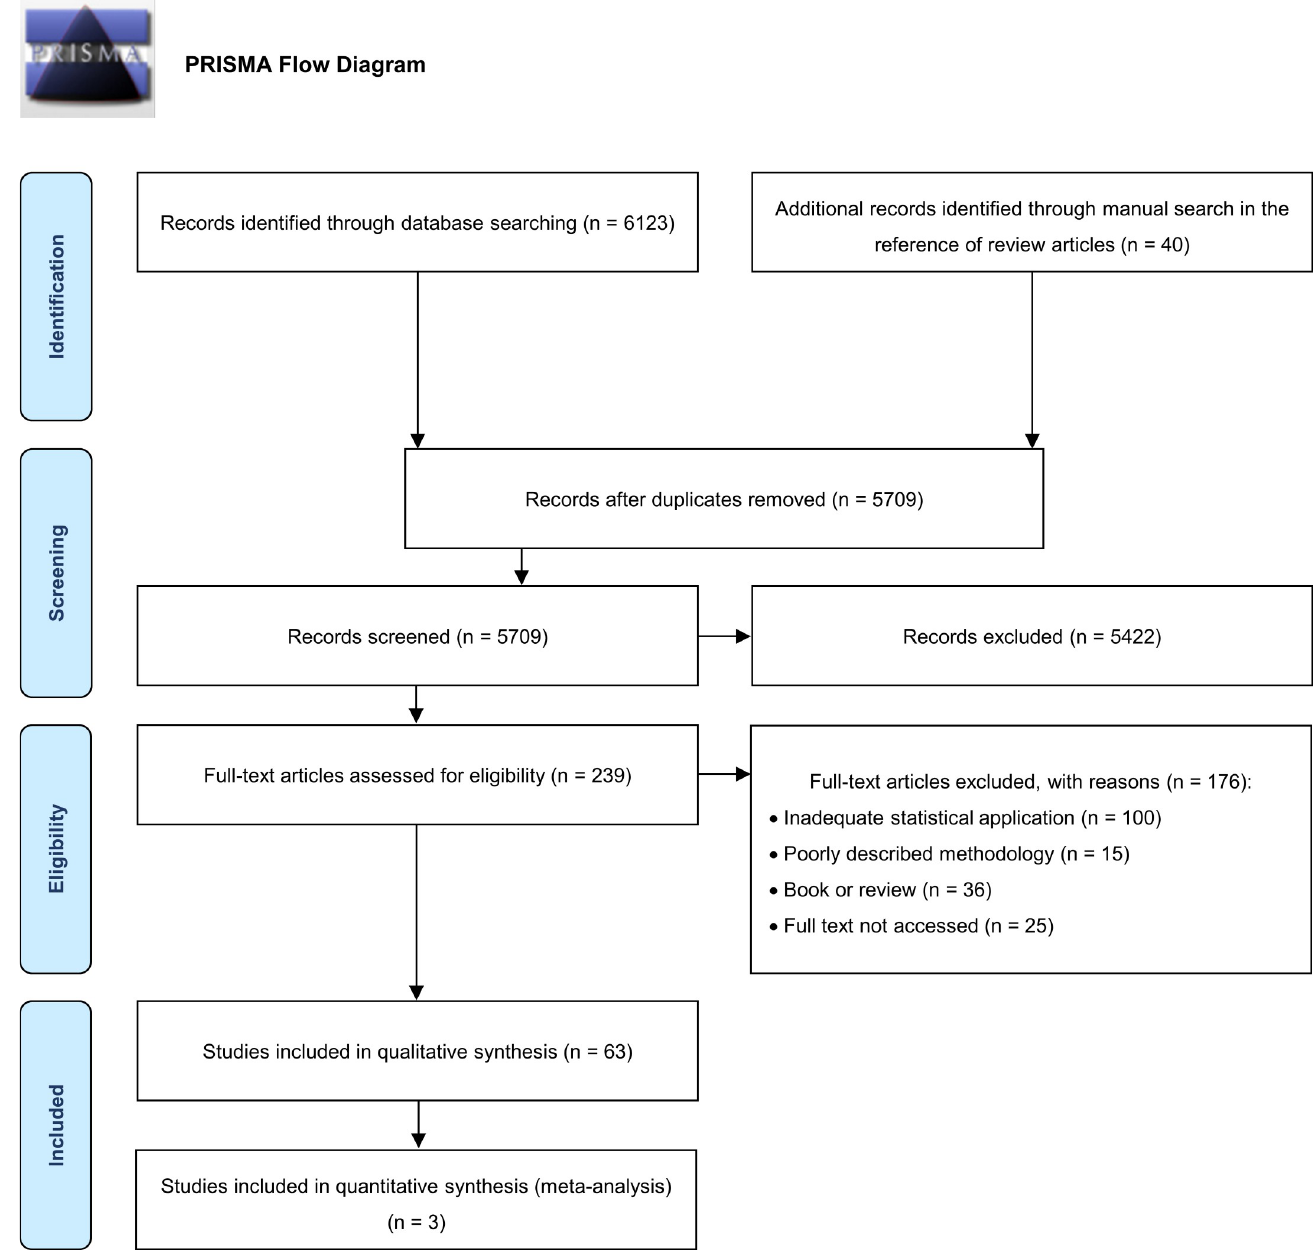
Fig 1. PRISMA Flow diagram of selected